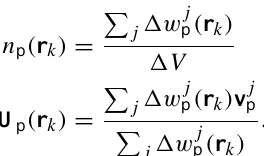
1V , then the grid cell